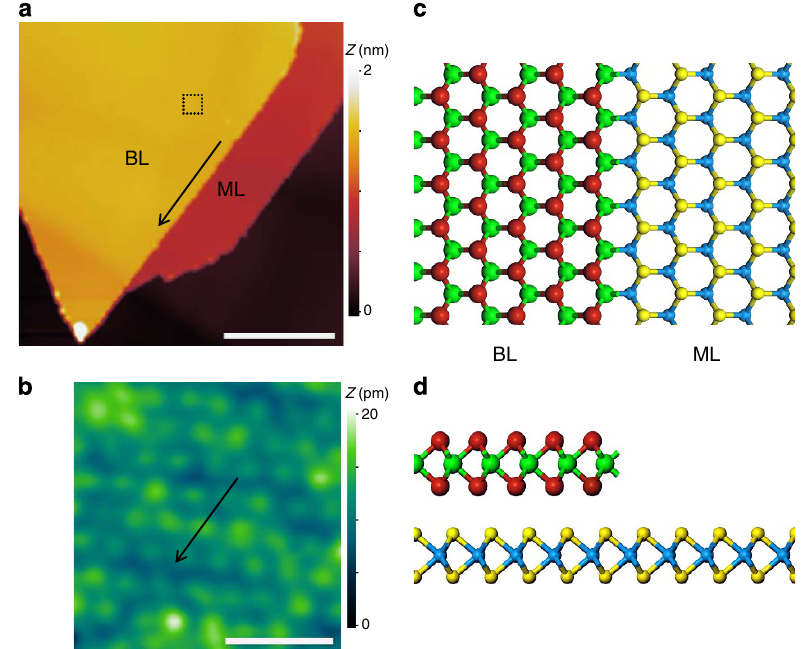
Figure 1 | STM images and schematic models of BL–ML TMD lateral heterojunctions. ( a ) STM image for a naturally formed BL–ML WSe 2 HJ grown on HOPG by chemical vapour deposition. The bilayer and monolayer regions are labelled as shown. ( b ) Atomic resolution image taken on bilayer region where a dash square is labelled in a (not to scale). The sample biases and tunnelling currents used are ( a ) 3V, 8pA, ( b ) (cid:2) 1.0V, 10pA. The arrows in a and b indicate the zig-zag orientation of the bilayer–monolayer interface. ( c,d ) Schematic models of the BL–ML heterojunction viewing from top and side, respectively. The green and cyan represent the metal atoms in second and first layer respectively, while the red and yellow corresponding for chalcogen atoms. Scale bar, 100nm ( a ); 1nm ( b